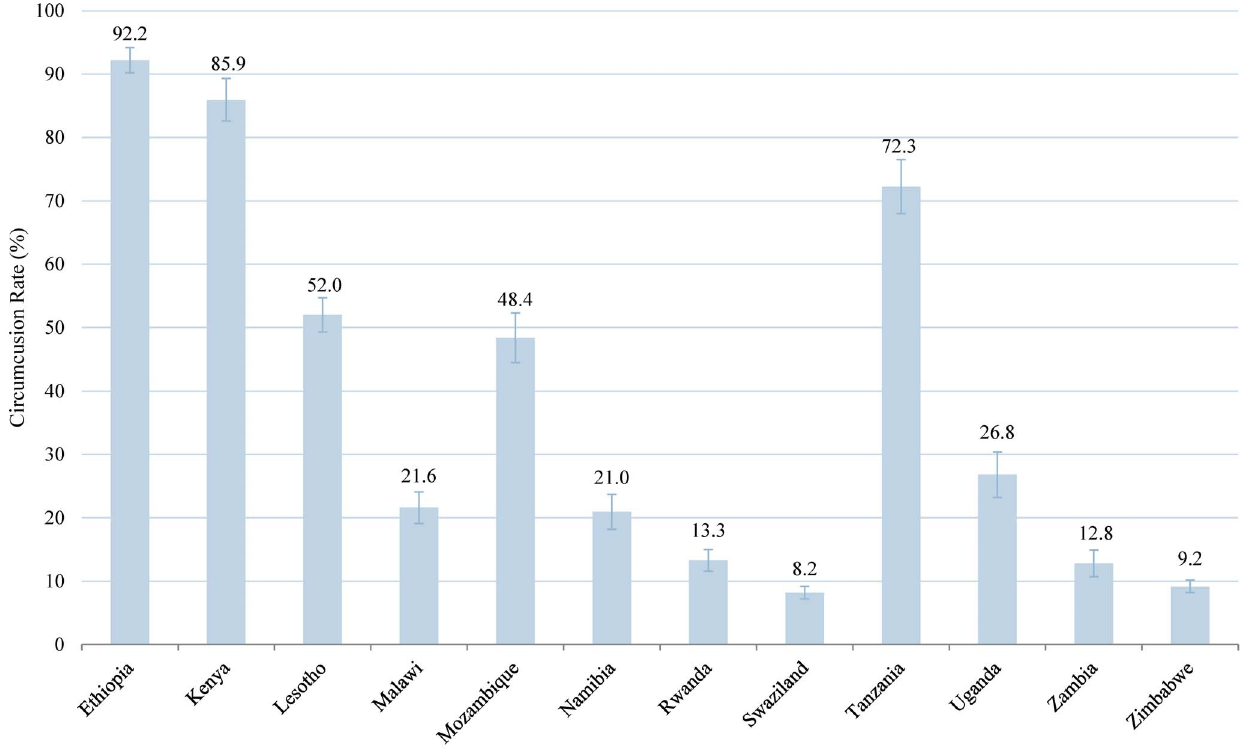
Figure 1. Male Circumcision Rates in Eastern and Southern African Countries. Percent circumcised among males in 12 Eastern and Southern African countries. We calculated these rates based on DHS survey data from the most recent years available. Error bars represent 95% CI.